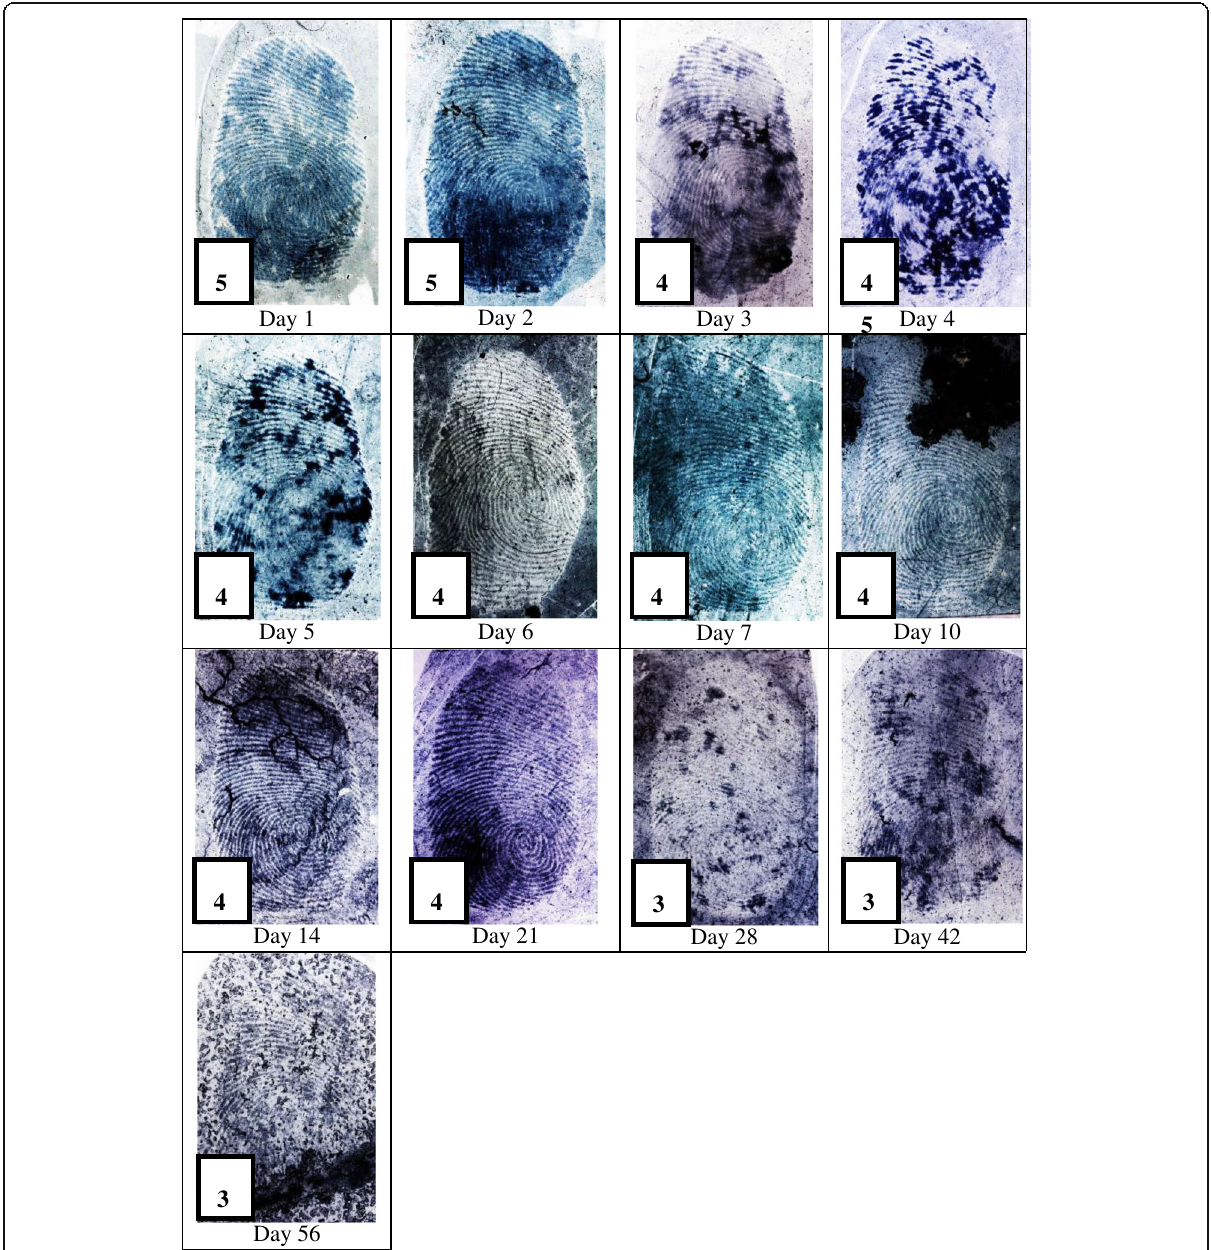
Fig. 15 Fingermarks recovered from the “ face up ” surface of the metal plates from day 1 to day